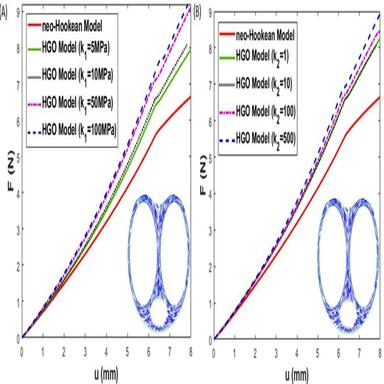
Influence of parameters (A) k1 (k2 = 10) and (B) k2 (k1 = 10 MPa) used in TA on the overall response of penile tissue in compression test.